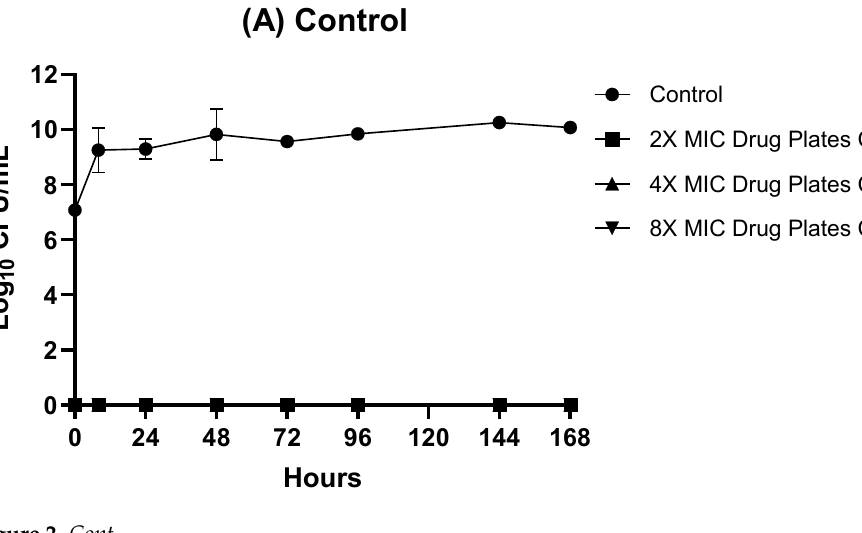
Figure 1. Mean reduction in bacterial density during 7-day HFIM assays (in duplicate) with the XDR P. aeruginosa index isolate treated with different Css of CAZ-AVI (12, 18, 30 and 48 mg/L) in CI. CFU, colony-forming unit; CI, continuous infusion; Css, steady-state concentration; MIC, minimum inhibitory concentrations. Errors bars are expressed as standard deviations (SD).